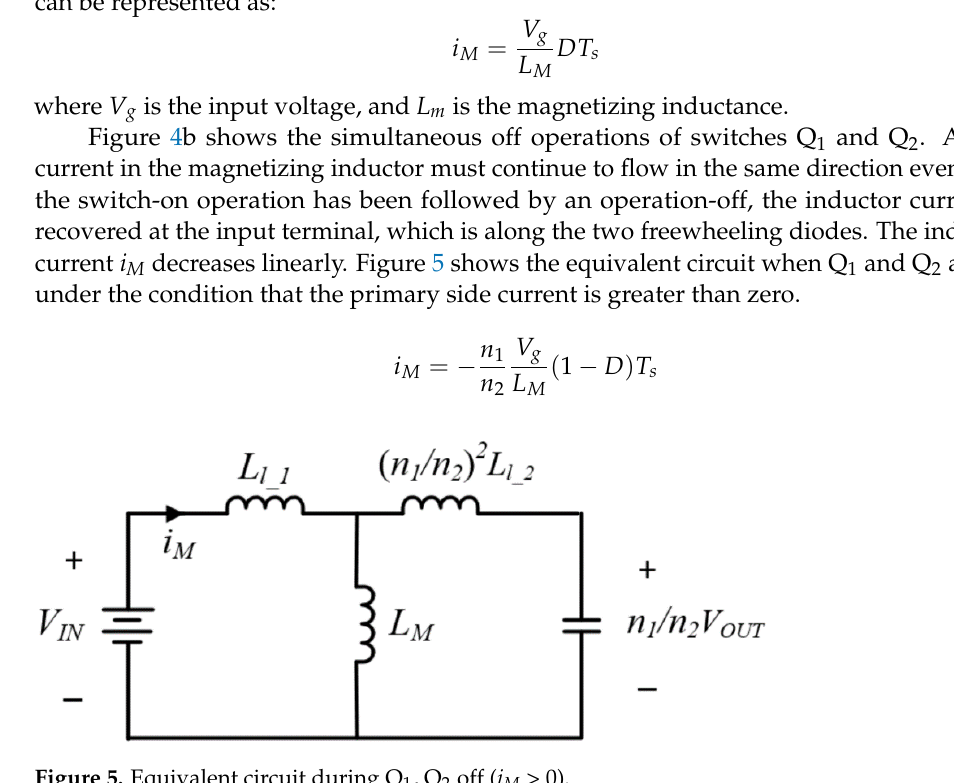
Figure 5. Equivalent circuit during Q 1 , Q 2 off ( i M > 0).